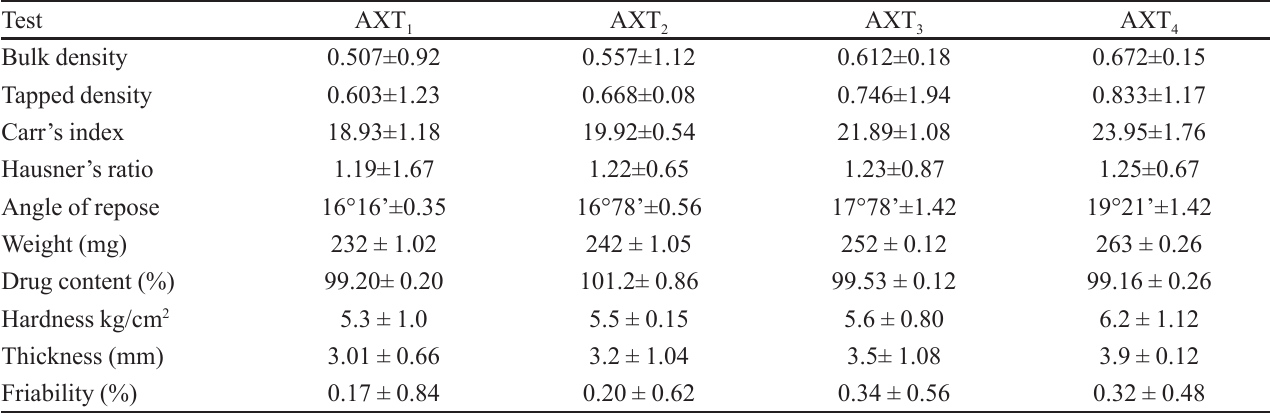
TABLE II - Physical and micromeritic properties of aceclofenac and xanthan gum granules Test